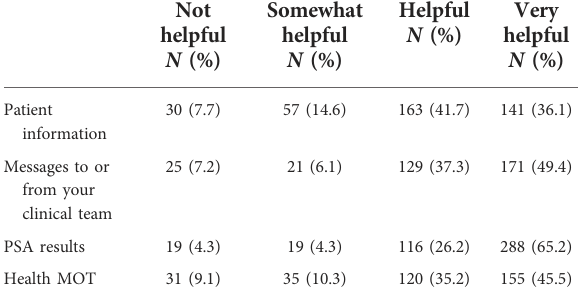
TABLE 5 Aspects of portal that helped users manage their